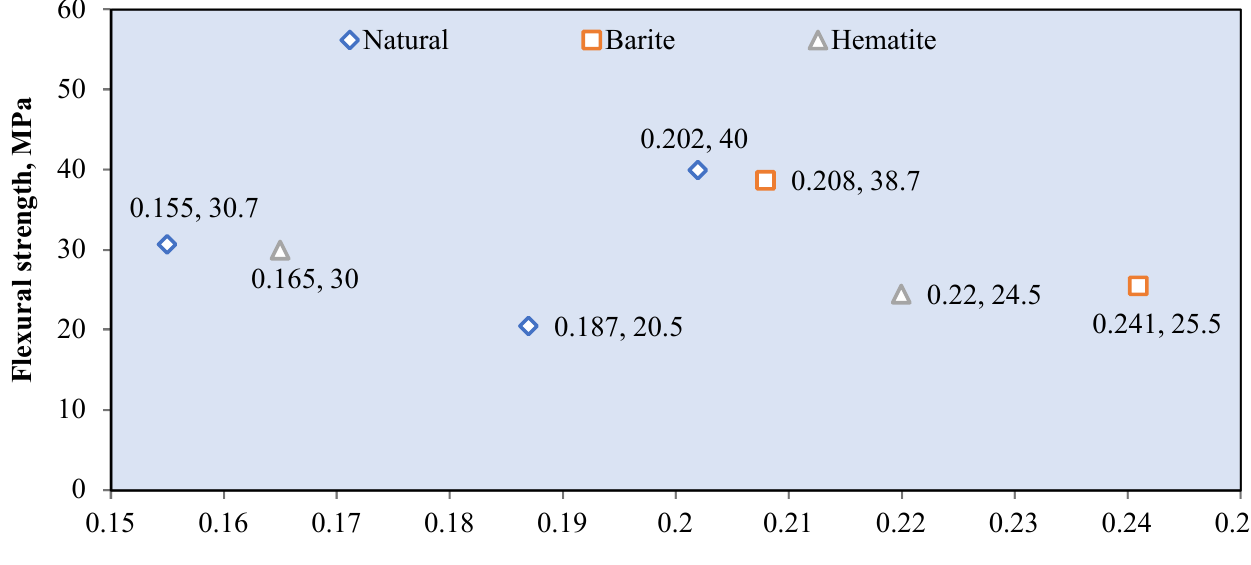
Figure 16. Flexural strength and linear attenuation coefficient based on 0.662 MeV gamma exposure on various RSCs with steel fiber additive (data adapted from [18,24,45,46]).